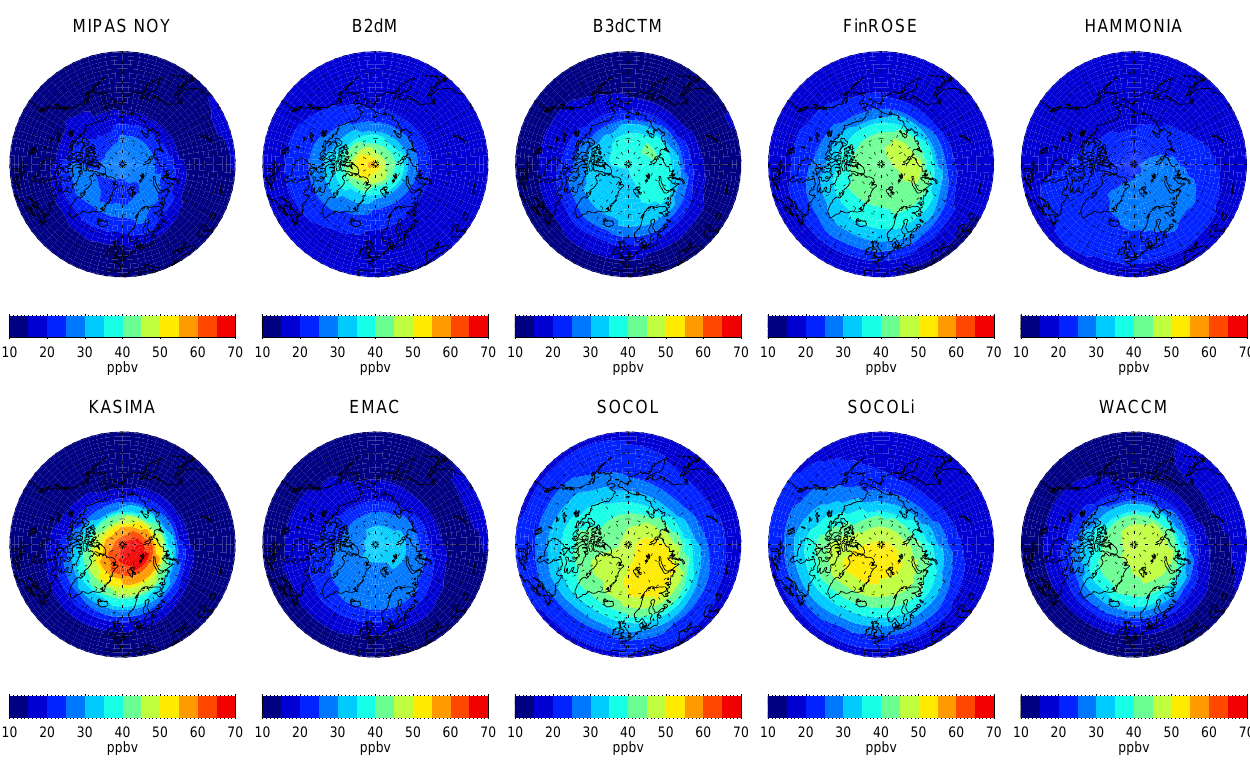
Fig. 17. Spatial distributions of observed and modeled NO y at 2hPa averaged of the period 20–27 November.